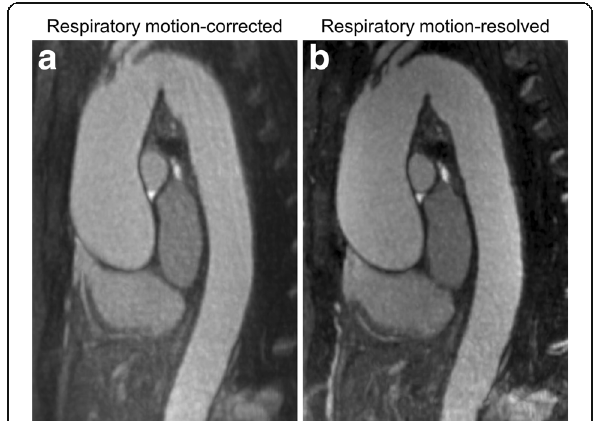
Fig. 1 Representative images from a 66-year-old woman with ascending aorta dilation. Maximum intensity projection MRA images displayed as 3-mm thick slabs are shown in the candy cane view of the aorta reconstructed using motion-corrected ( a ) and motion- resolved ( b ) algorithms in end-expiratory phase. While the image quality of both datasets was rated the best, the improved sharpness and overall image quality achieved by the motion-resolved reconstruction can be clearly observed